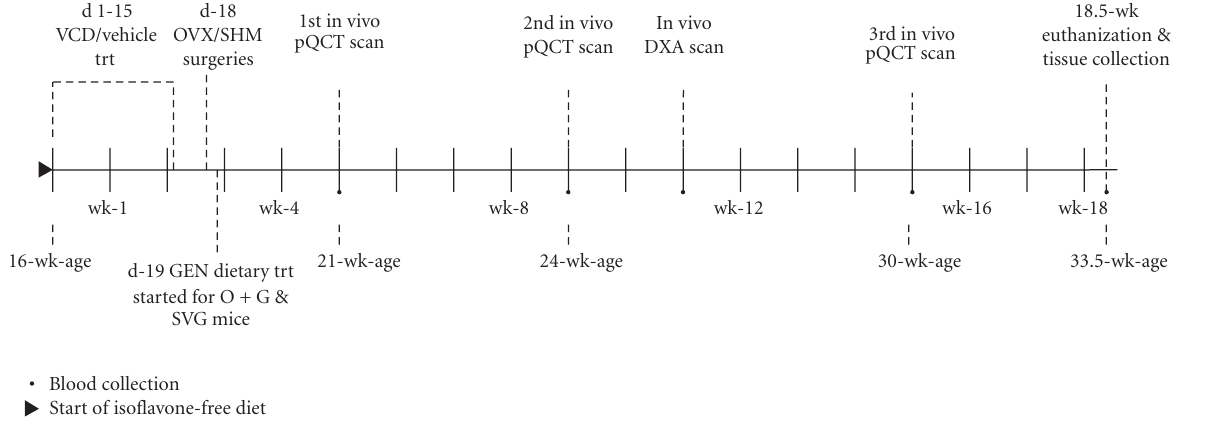
Figure 1: Experimental timeline.